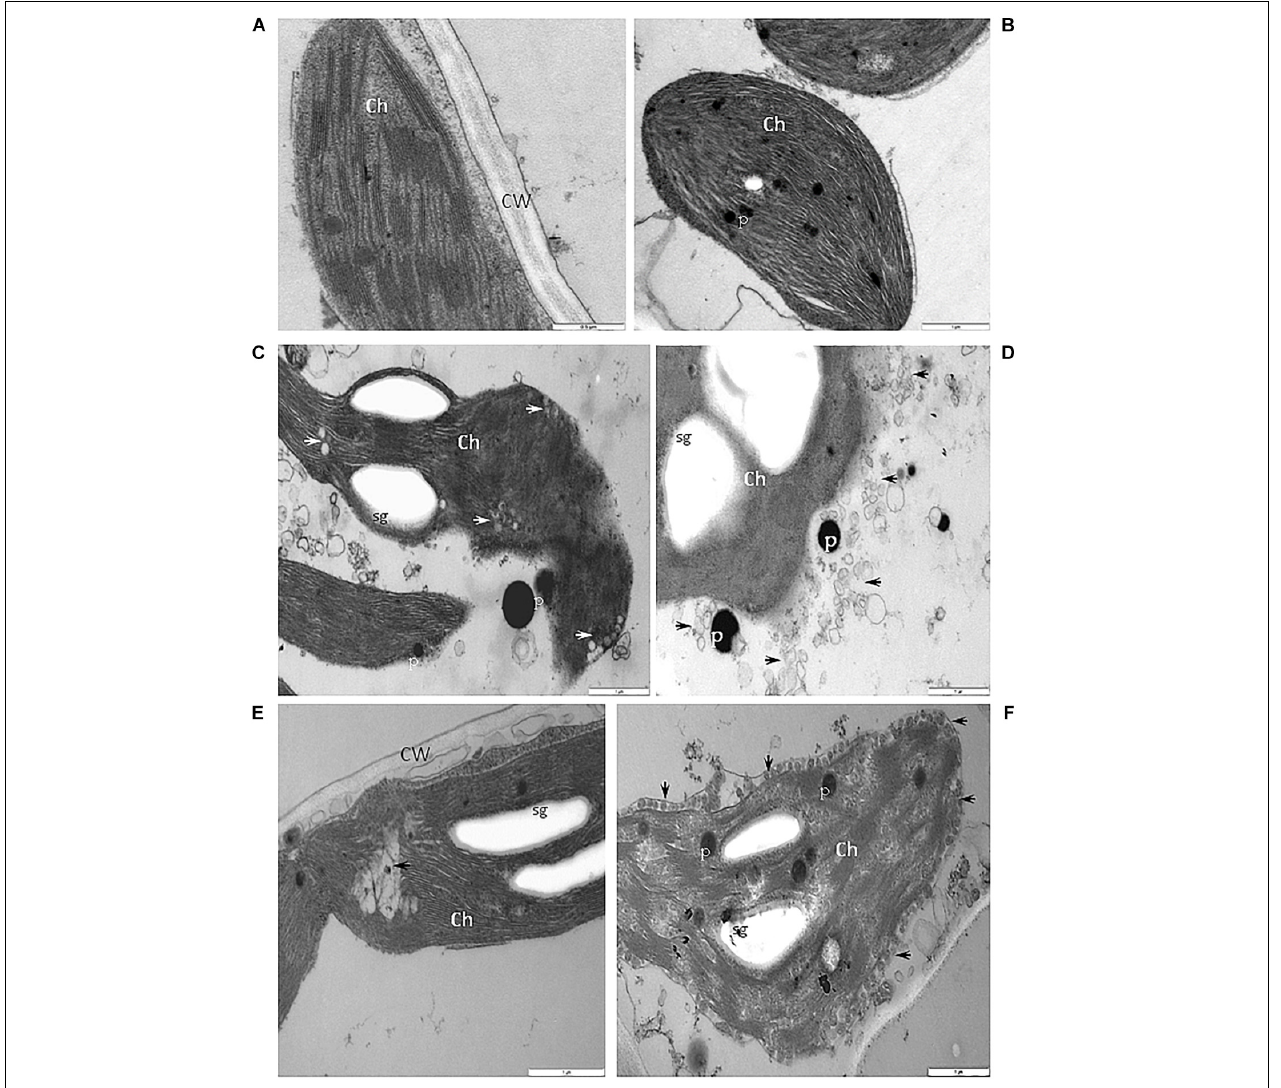
FIGURE 7 | Alterations of the structure of chloroplasts in cells of BPEV-infected tissues. (A) Chloroplast (Ch) of a BPEV-free mesophyll cell. CW-cell wall. Bar 0.5 µ m. (B) Abnormal structure of thylakoids. Ch-chloroplast, P-plastoglobules. Bar 1 µ m. (C) Alteration of the chloroplast (Ch) morphology and small vesicles inside stroma (arrows). P-plastoglobules, sg-starch grains. Bar 1 µ m. (D) Small vesicles (arrows) and plastoglobules (P) between the chloroplast (Ch) and the chloroplast membrane. sg-starch grains. Bar 1 µ m. (E) Electron lucent area (arrow) inside chloroplast (Ch). CW-cell wall, sg-starch grains. Bar 1 µ m. (F) Small vesicles (arrows) of stroma fragmentation and altered chloroplast (Ch) envelope. P-plastoglobules, sg-starch grains. Bar 1 µ